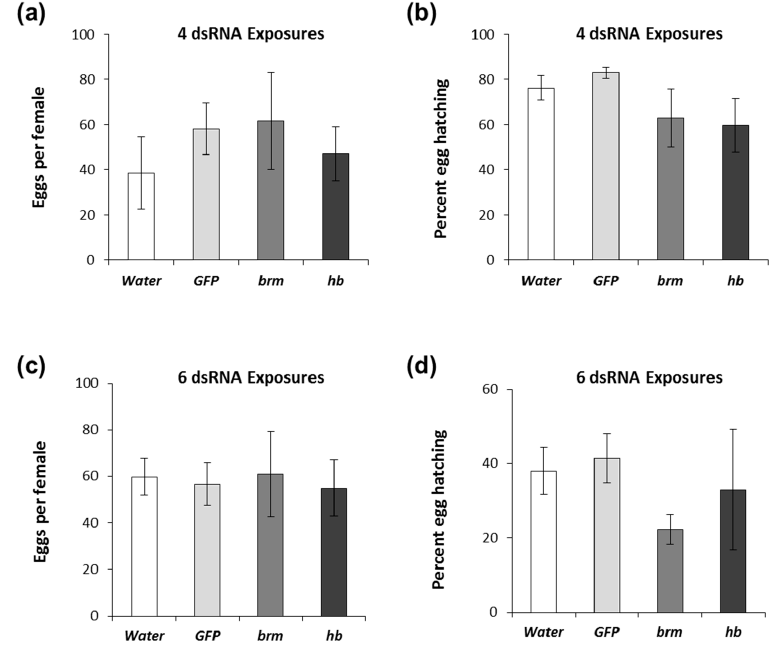
Figure 6. pRNAi response to brahma ( brm ) and hunchback ( hb ) dsRNA of D. v. virgifera males. Males were fed with diet treated with 2 µ g dsRNA. Treatment was provided four and six times every other day and mated with females immediately after receiving all dsRNA treatments. ( a ) Eggs collected from females mated with males with four dsRNA exposures; ( b ) Eggs hatched based on numbers oviposited; ( c ) Eggs collected from females mated with males with six dsRNA exposures; ( d ) Eggs hatched based on numbers oviposited. Comparisons performed with Dunnett (cid:48) s test (control group = water), * significance at p <